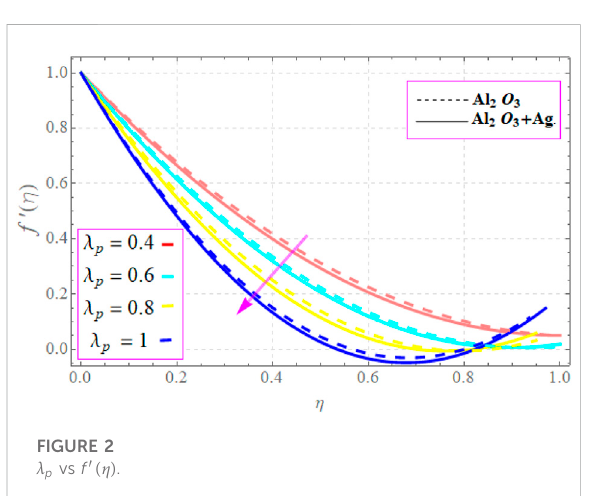
FIGURE 2 λ ′ ( η ) . p vs f